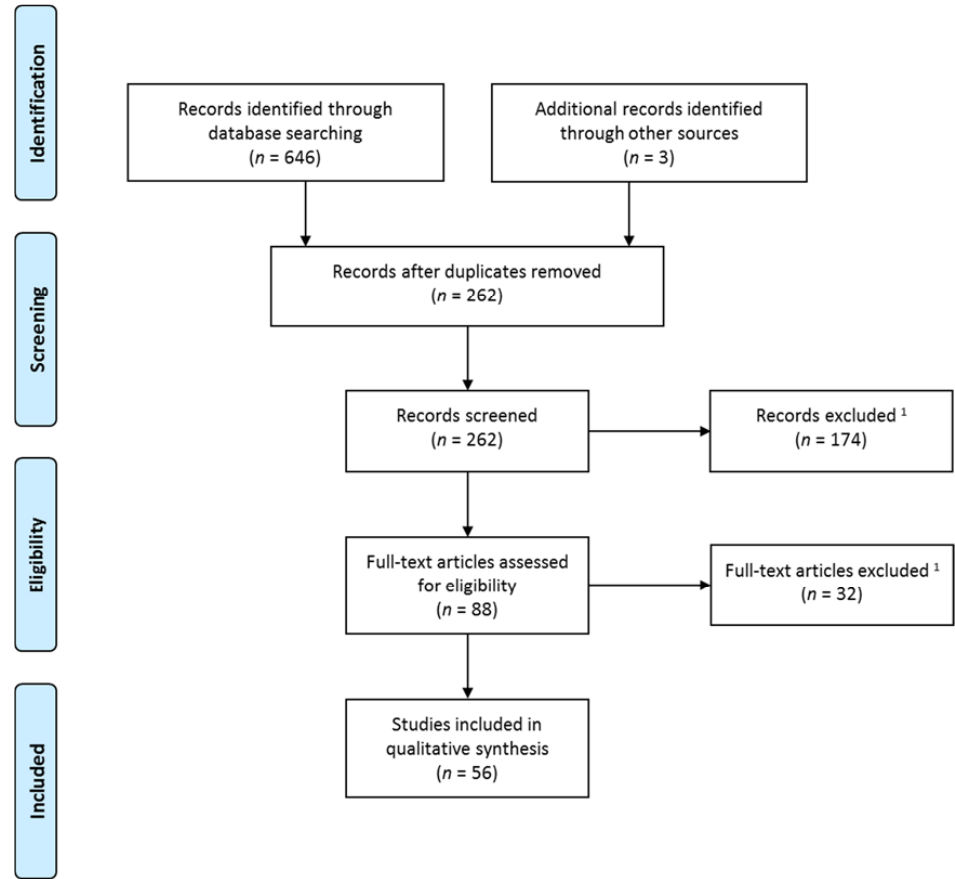
Figure 1. Flow chart describing the selection process of the studies included (adapted from Moher